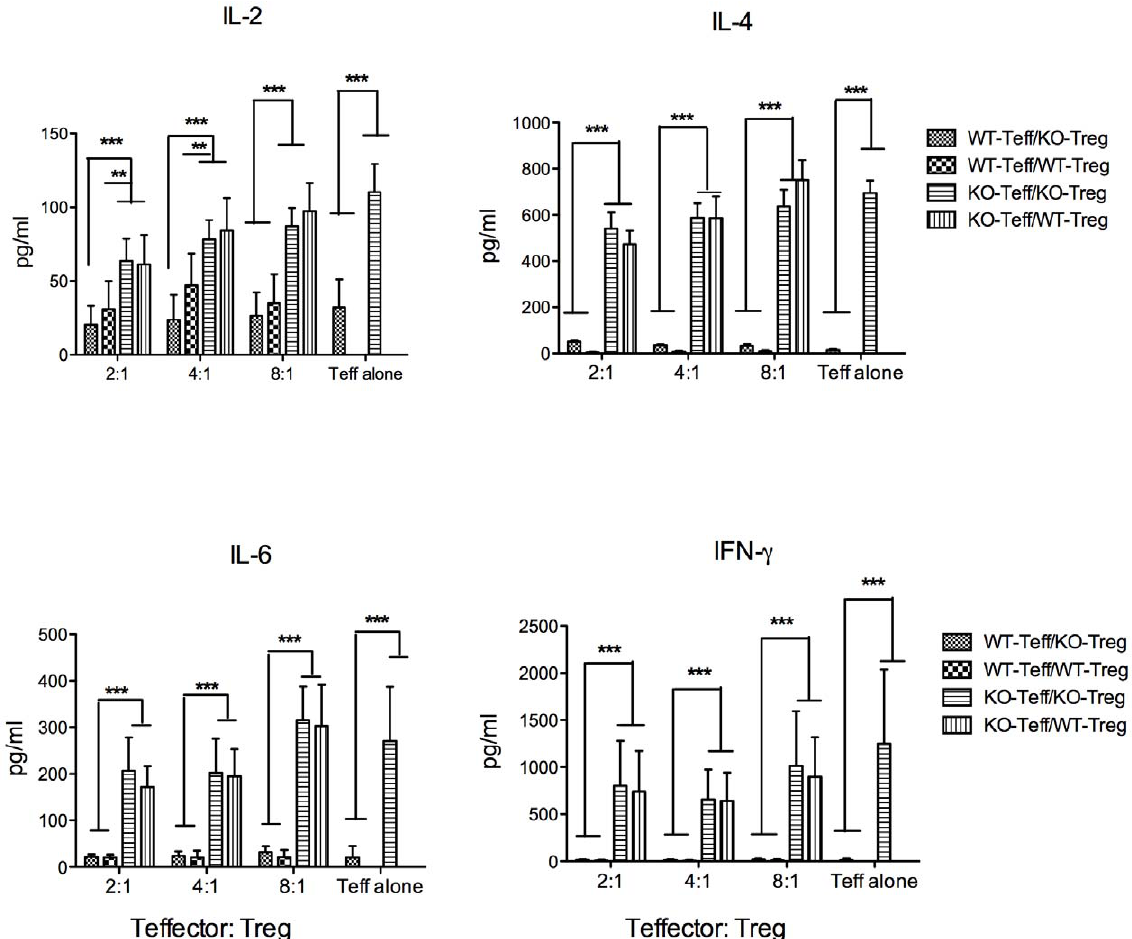
Figure 7. Cytokine production in the suppression assay co-cultures. Supernatants were harvested after 48 hours and assayed for IL-2, IL-4, IL-6 and IFN- c by CBA analysis. Means 6 SEM of cytokine levels from the collected supernatants in two of the triplicate wells are shown. Results presented are from 3 independent experiments, where **=p # 0.01 and ***=p # 0.001.